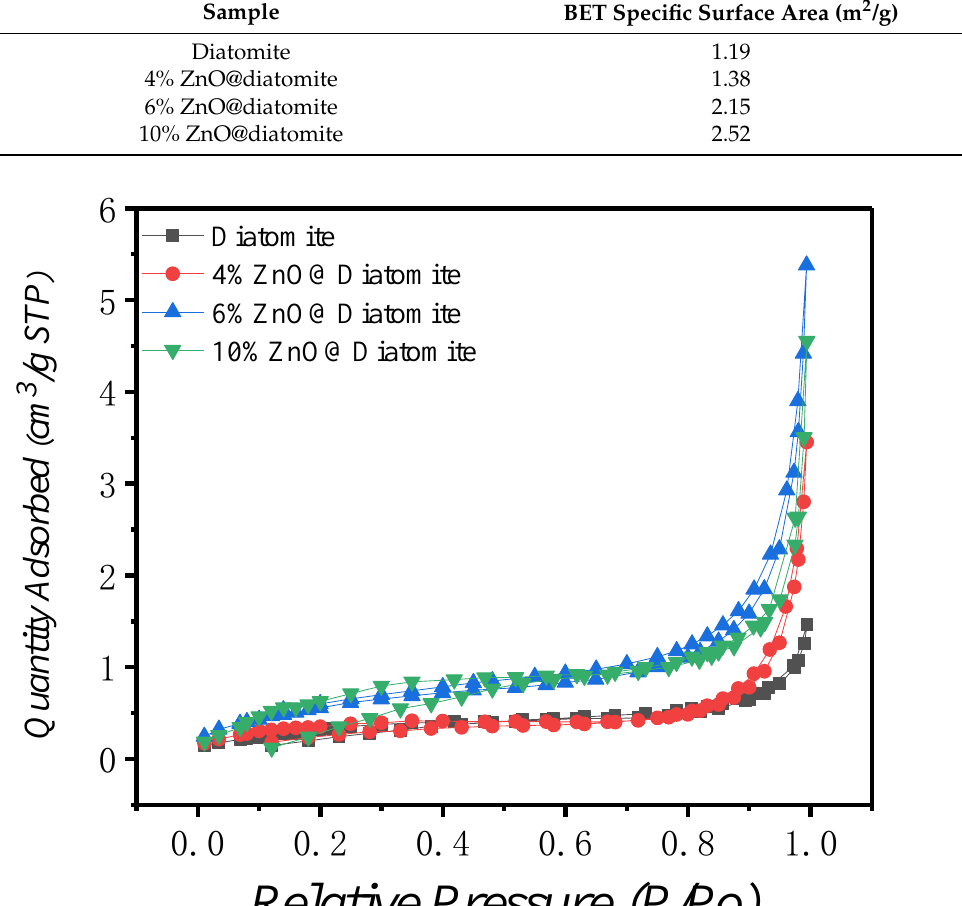
Figure 6. N 2 adsorption-desorption isotherms of diatomite and X% ZnO@diatomite composites.